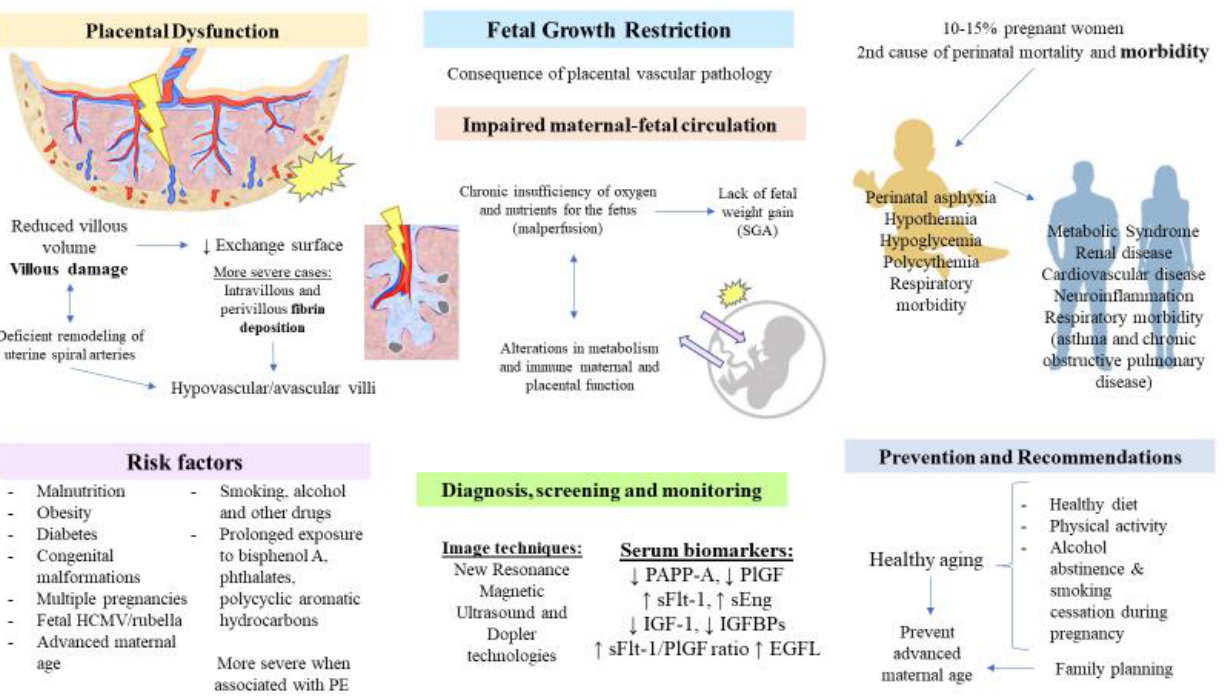
Figure 3. The vital role of the placenta in fetal growth restriction, risk factors, and consequences of the impaired maternofetal circulation. Main diagnosis, screening, and monitoring methods, as well as some preventive measures and recommendations, are also